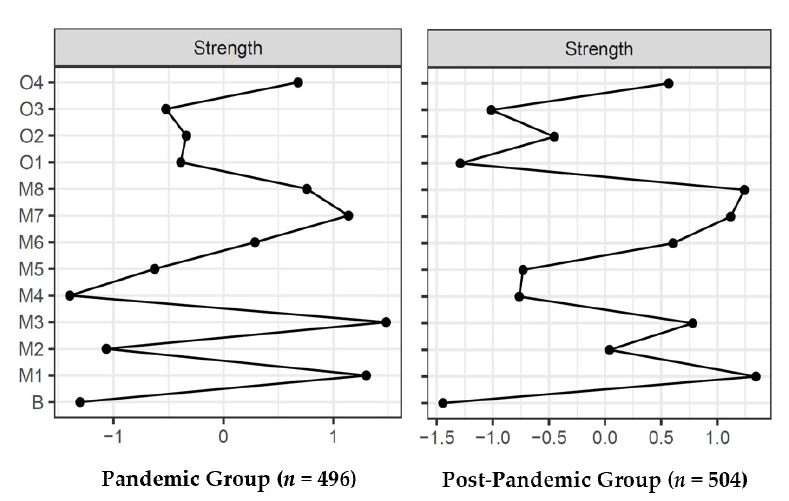
7 of 17 Figure 1. Network topology for PUM, OSA, and BPS by group. Green color edges represent positive, and red color edges represent negative associations, all lines in both networks are green. Thickness and saturation of edges indicate the strength of associations. The filled part of the pie chart around each node shows the predictability of each node, representing the variance of the nodes explained by other nodes in the networks. 3.2.2. Node Centrality Bootstrap stability analyses indicated that the closeness and betweenness ( CS coefficients < 0.5) estimates were not as stable as strength ( CS coefficients = 0.75). According to the recommended value of the stability coefficient [73], we limited the interpretation of centrality statistics to strength centrality (i.e., the absolute sum of edge weights attached to a node). The z-score value of the strength for each node in the network is shown in Figure 2. There was a high similarity in the pattern of node centrality for the pandemic and post-pandemic groups. Specifically, using the NCT, we found that nodes with the highest strength centrality estimates were sexual pleasure (M1, diff = − 0.02, p = 0.859), stress reduction (M7, diff = 0.01, p = 0.956), fantasy (M3, diff = 0.13, p = 0.105), and self-exploration (M8, diff = − 0.08, p = 0.300), in both networks. Nevertheless, NCT showed that there were significant differences on the point of O1 (viewing SEM, diff = 0.28, p = 0.004) and BPS (diff = 0.17, p = 0.005). BPS was significantly higher in the pandemic group